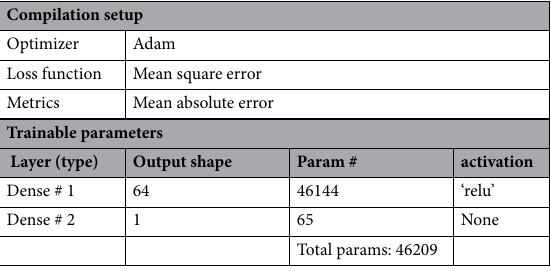
Table 2. Compilation setup and parameters of the feed forward